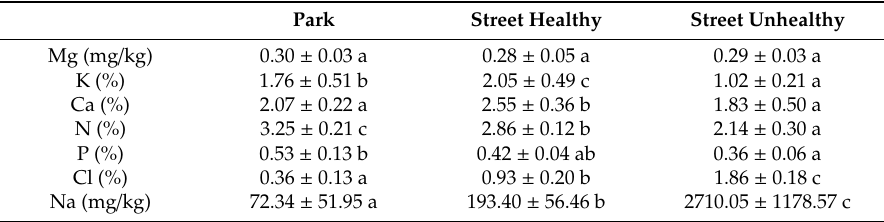
Table 4. Chemical composition of Crimean linden leaves growing in the streets ( n = 16) and in the park area ( n = 8) as well as p -values based on ANOVA. Park Street Healthy Street Unhealthy